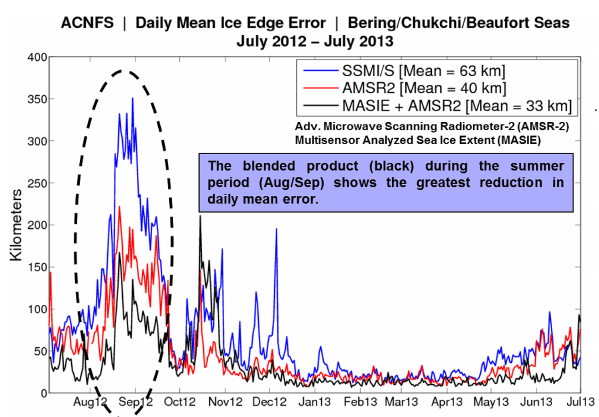
Figure 8. Daily mean error (km) for the Bering/Chukchi/Beaufort Seas versus time for ACNFS ice edge (define as the 5% ice con- centration) against the independent ice edge analysis from the NIC over the validation period 1 July 2012–1 July 2013. The blue line shows the use of SSMIS assimilation only, the red line shows the use of AMSR2 assimilation only and the black line shows the use of the blended AMSR2 + MASIE